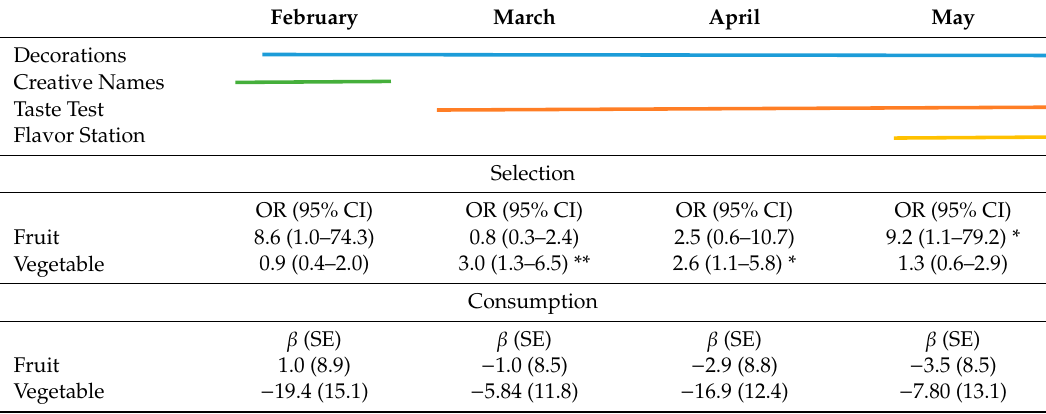
Table 5. Intervention component timeline and corresponding regression analyses examining changes in fruit and vegetable selection and consumption over time at School 3.